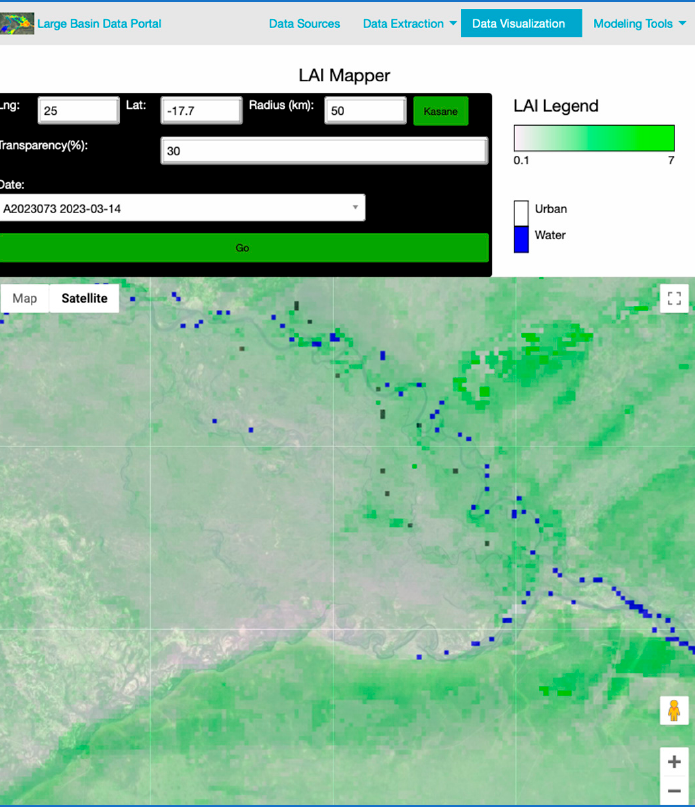
Figure 8. Screenshot of the Large Basin Data Portal Leaf Area Index (LAI) mapper with input parameters and the displayed map of the eastern section of the Chobe–Zambezi flood plains, Africa. The green shading overlay reflects various levels of LAI on 14 March 2023, based on data derived from the MODIS MOD15A2H dataset. The darker green areas represent areas with higher LAI (areas with higher plant/tree density).